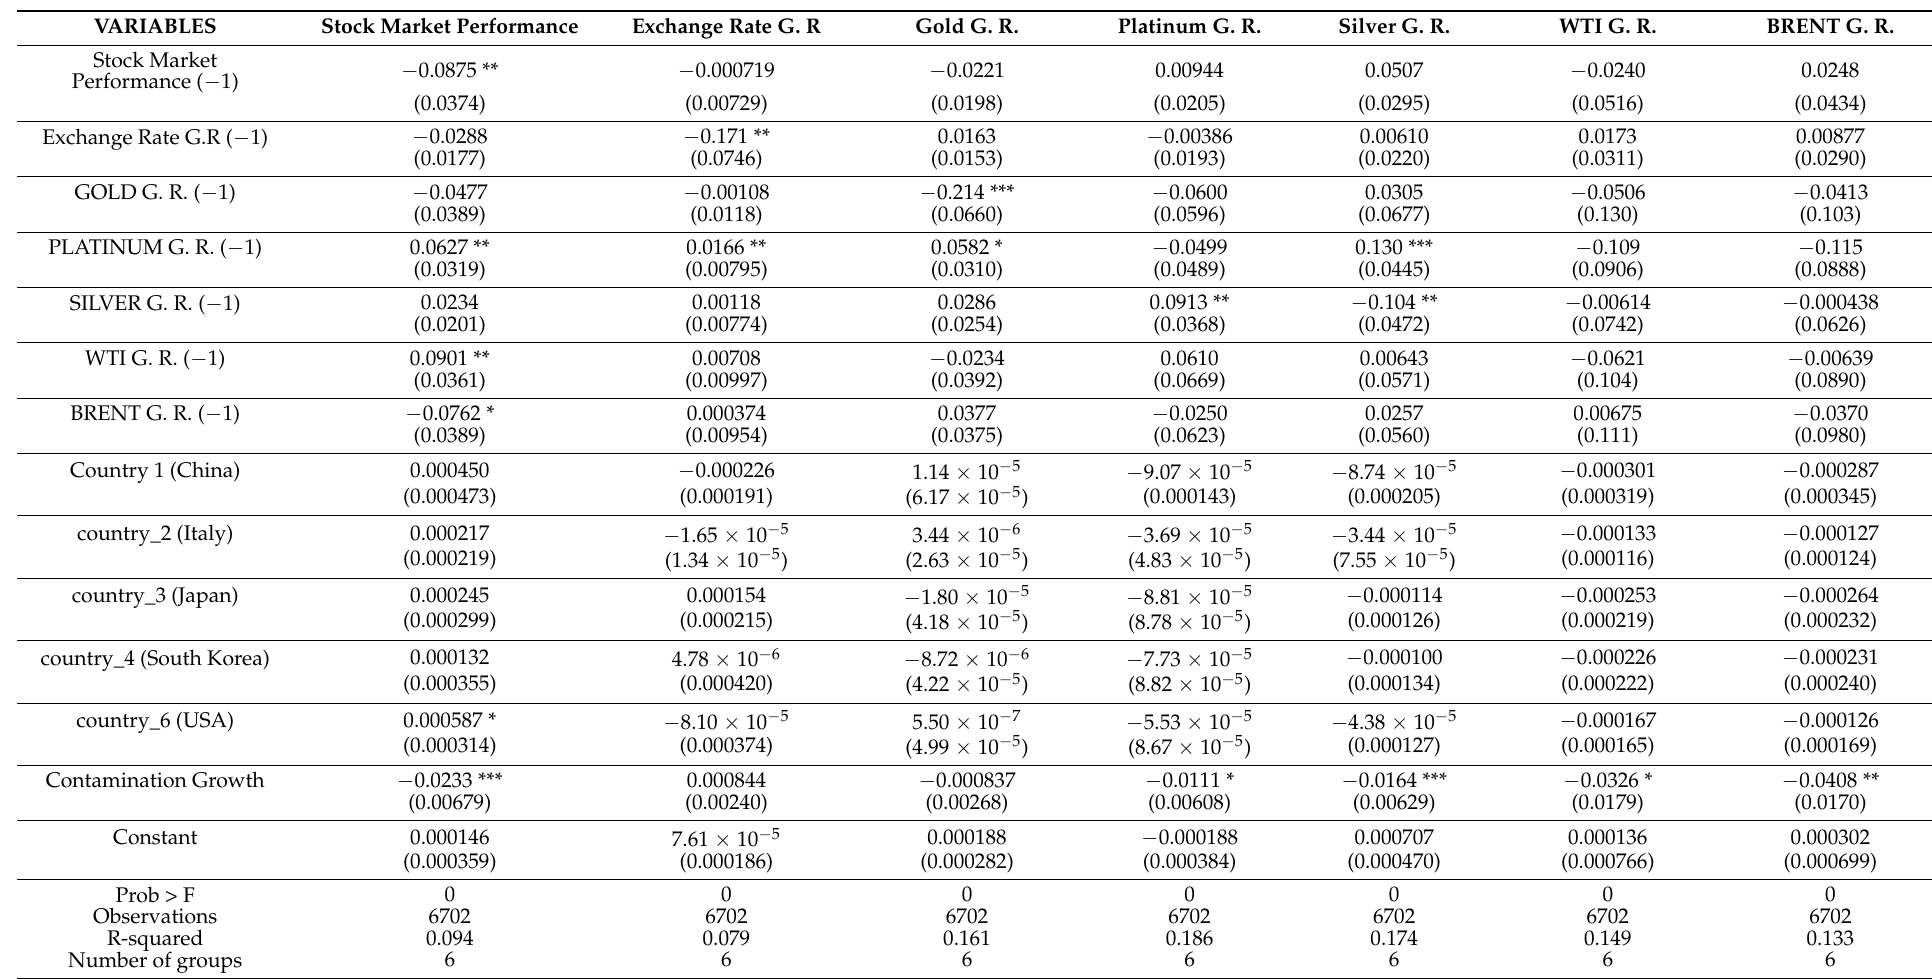
Table A7. Regression with Driscoll–Kraay robust standard errors to autocorrelation, HT, and cross-sectional